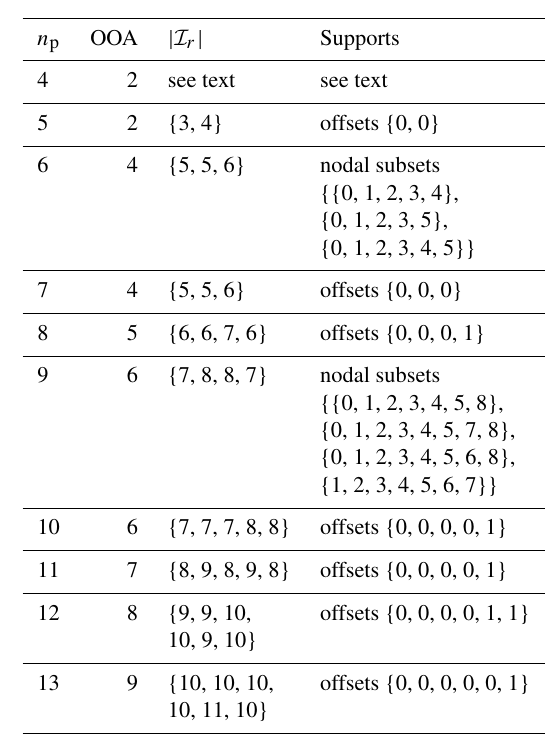
Table A1. Islet GLL nodal subset bases. Each row provides a for- mula for the row’s n p value. Columns are n p , order of accuracy (OOA), the support sizes | I r | for each region ordered left to mid- dle, and the supports. For offset nodal subset bases, supports are given by offsets. For general nodal subset bases, supports are given by nodal subsets, again ordered from left region to middle. The case n p = 4 is described in Appendix A1. In all cases, the support points are GLL nodes.